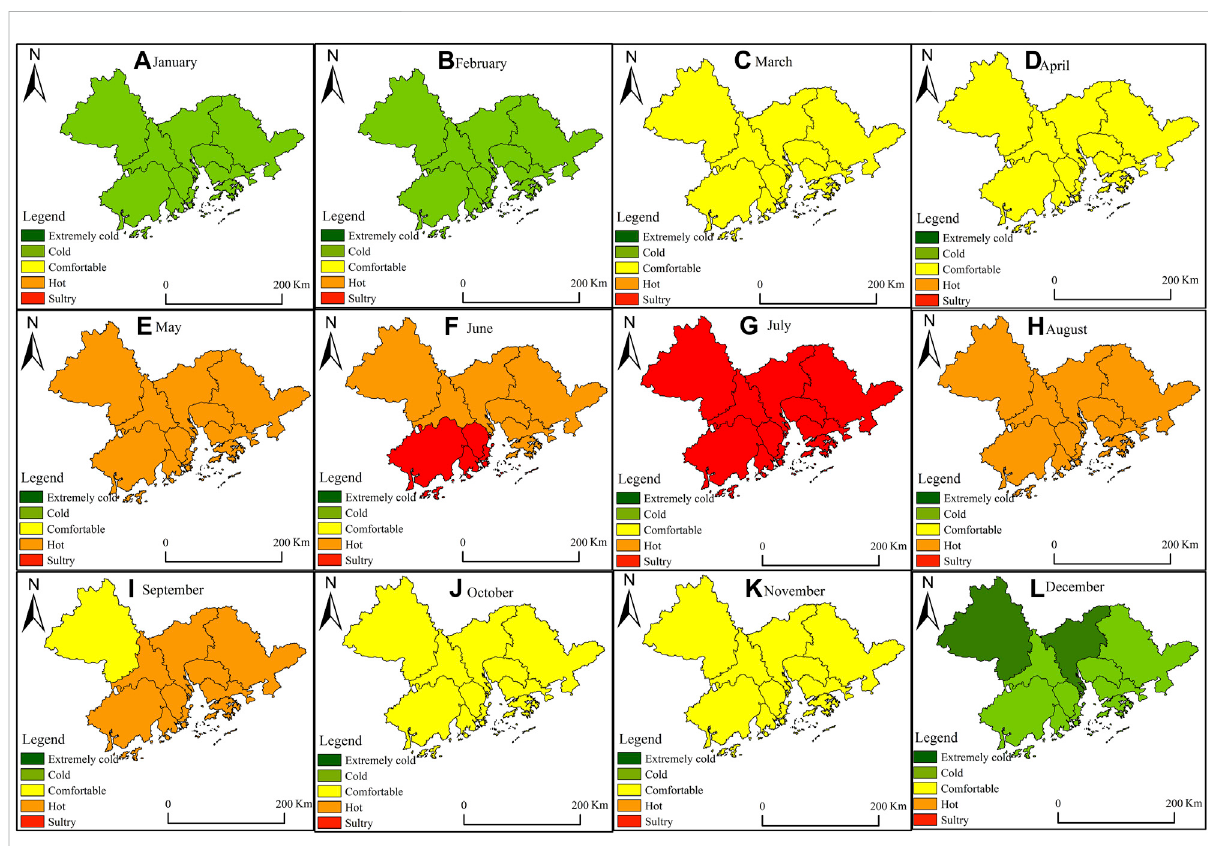
FIGURE 10 The monthly variation of the climate comfort of human settlements in the Guangdong – Hong Kong – Macau Greater Bay Area in 2020.